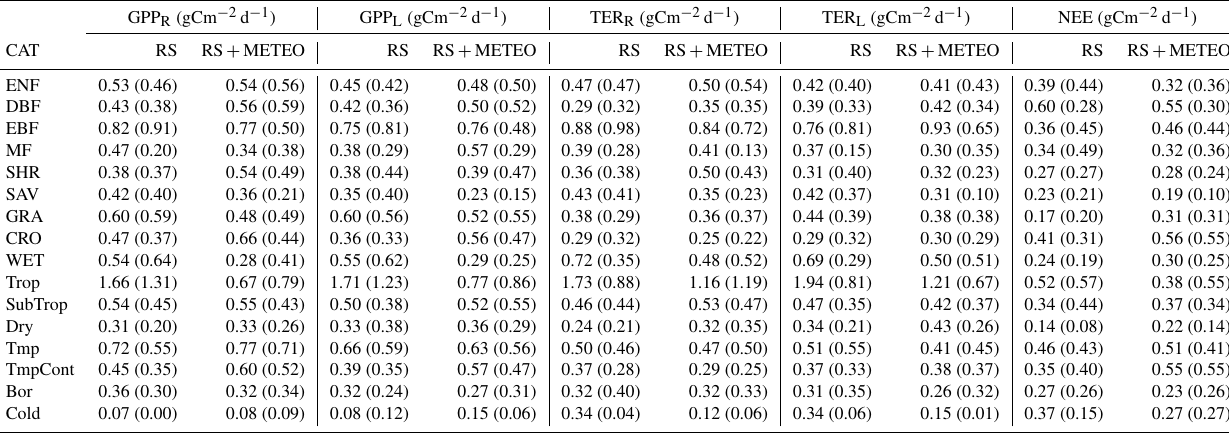
Table C3. Median site-by-site absolute bias and its standard deviation (in parentheses and estimated as reported in Jung et al., 2009) for the CO 2 fluxes per PFT and climate zone. List of acronyms: ENF, was evergreen needleleaf forest; DBF, deciduous broadleaf forest; EBF, evergreen broadleaf forest; MF, mixed forest; SHR, shrubland; SAV, savannah; GRA, grassland; CRO, cropland; WET, wetland; Trop, tropical; SubTrop, subtropical; Dry, dry and arid land; Tmp, temperate; TmpCont, temperate–continental; Bor, boreal; Cold, cold and polar environment or covered by ice.